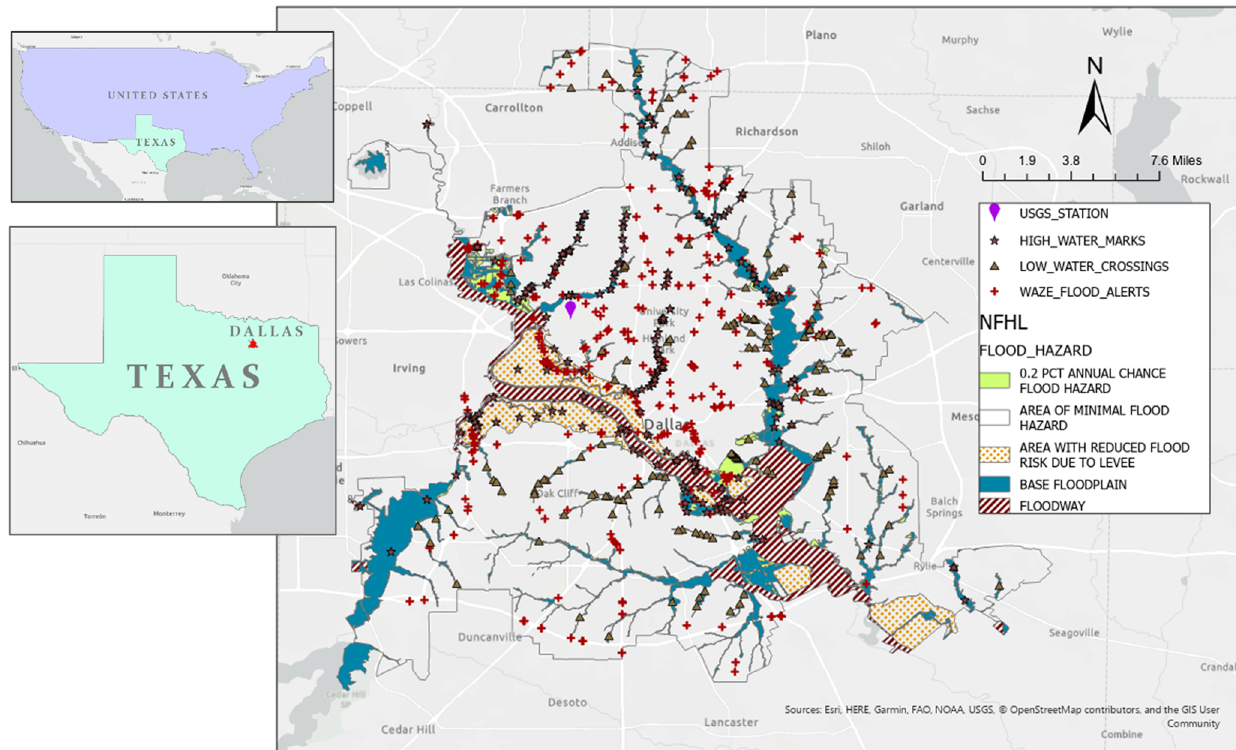
Figure 5. Study area and datasets (basemap from ESRI-2021).